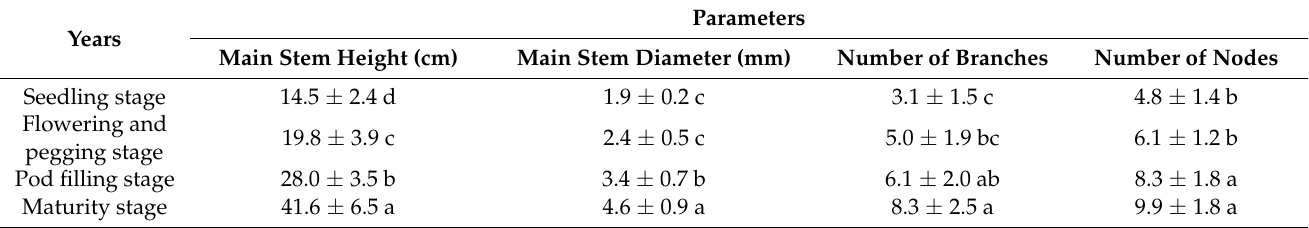
Table 2. Effect of different growth stages on plant growth parameters of peanut.